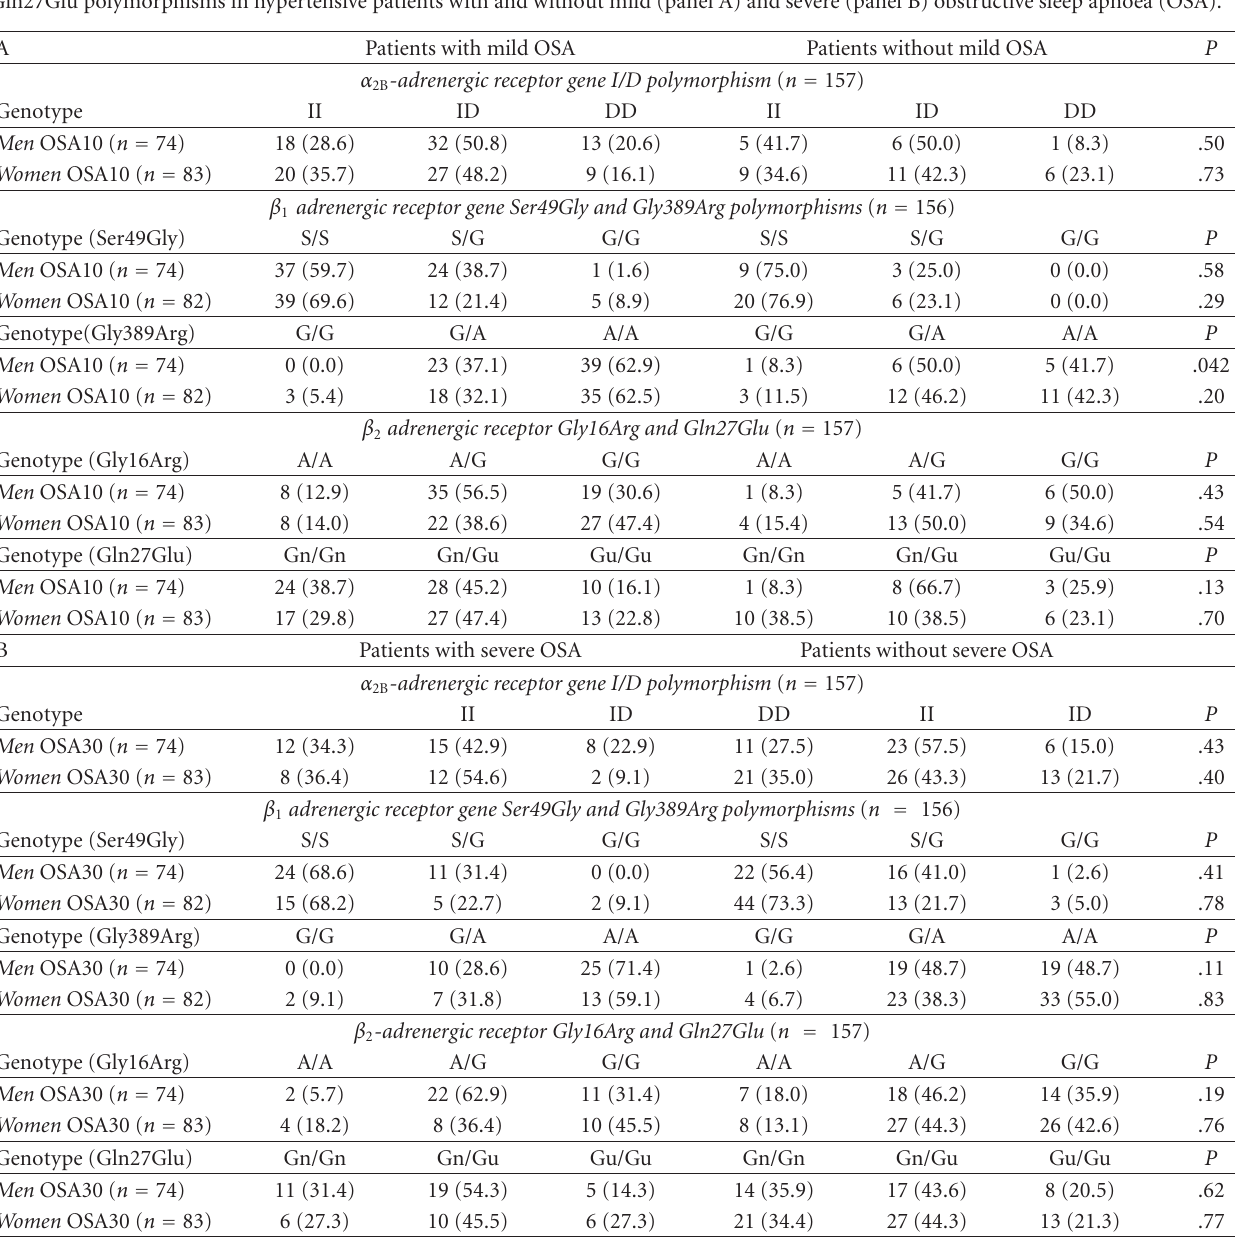
Table 3: Genotype frequencies of adrenergic receptor genes: α 2 B -adrenergic I/D, the β 1 Ser49Gly and Gly389Arg, and the β 2 Gly16Arg and Gln27Glu polymorphisms in hypertensive patients with and without mild (panel A) and severe (panel B) obstructive sleep apnoea